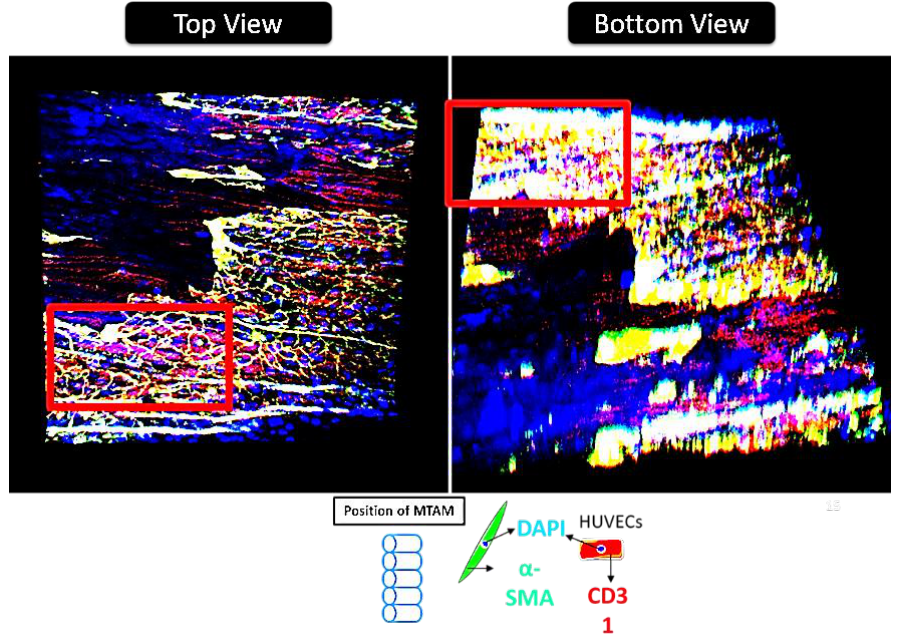
Figure 8. Confocal laser scanning electron microscopy (CLSM) of eight-week-old tissue engineered vascular graft (TEVG) (top view), and deconvolution microscopy (DM) of eight-week old tissue engineered vascular graft (TEVG) (bottom view). Red insert indicates indicate a similar site but a different view (i.e., top and bottom views). Red color regions indicate the presence of HUVECs, while yellow color regions are the result of overlaying of red (HUVEC) and green (SMC) colors. Blue color indicates the nucleus regions of the respective cells.